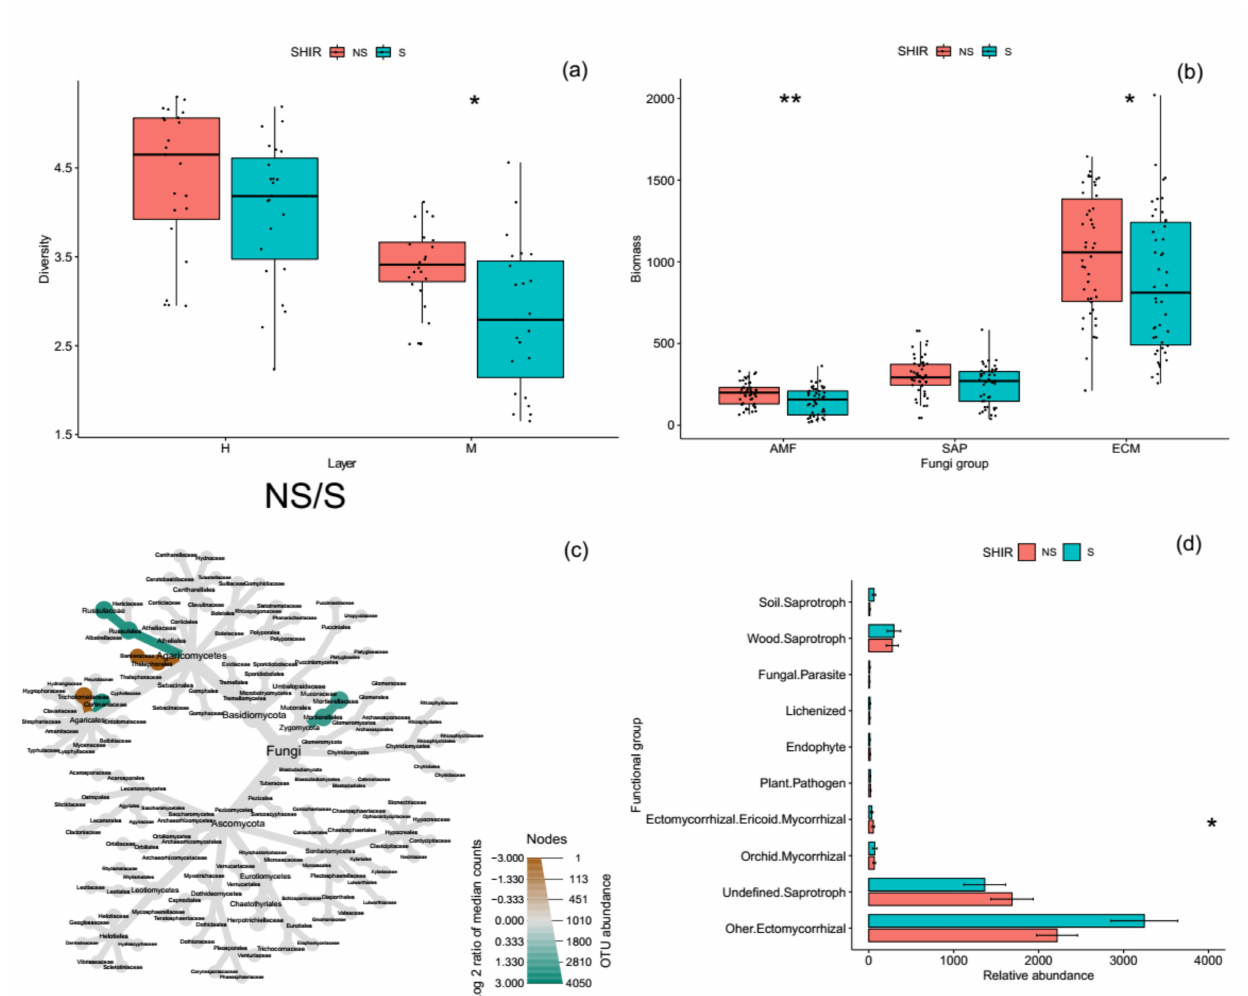
Figure 2. The changes of specific microbial groups based on, fungal diversity ( a ), phospholipid-fatty acid ( b ), fungi community composition ( c ), and their functions ( d ) in the shiro and non-shiro soil from all forest sites. * and ** indicate the significant differences between shiro and non-shiro soils at p < 0.05 and p < 0.01,